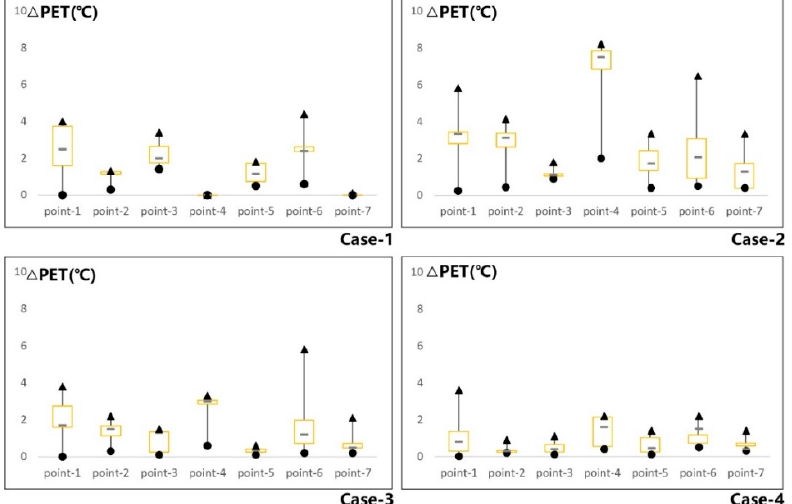
Figure 18. New PET distribution in different cases at 14:00 during the measured day. Energies 2019 , 12 , x FOR PEER REVIEW